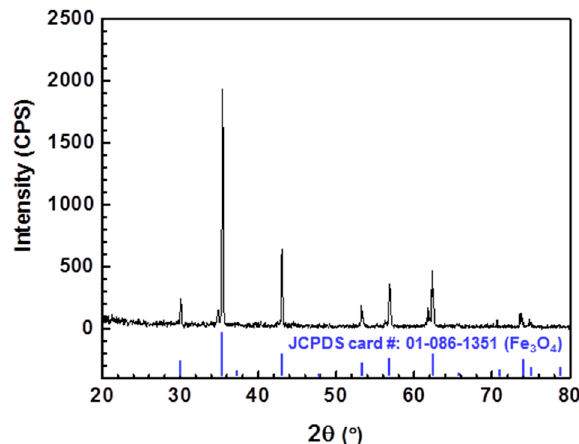
Figure 4. X-ray diffraction patterns of the electrodeposited magnetite layer.